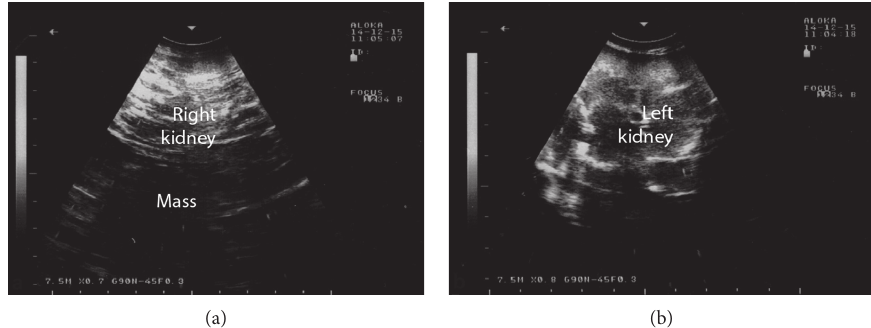
Figure 19: Transrectal ultrasonographic findings in a female camel with renal cell carcinoma of the right kidney. Image (a) shows a hypoechoic mass involving the right renal parenchyma, while image (b) shows the normal left